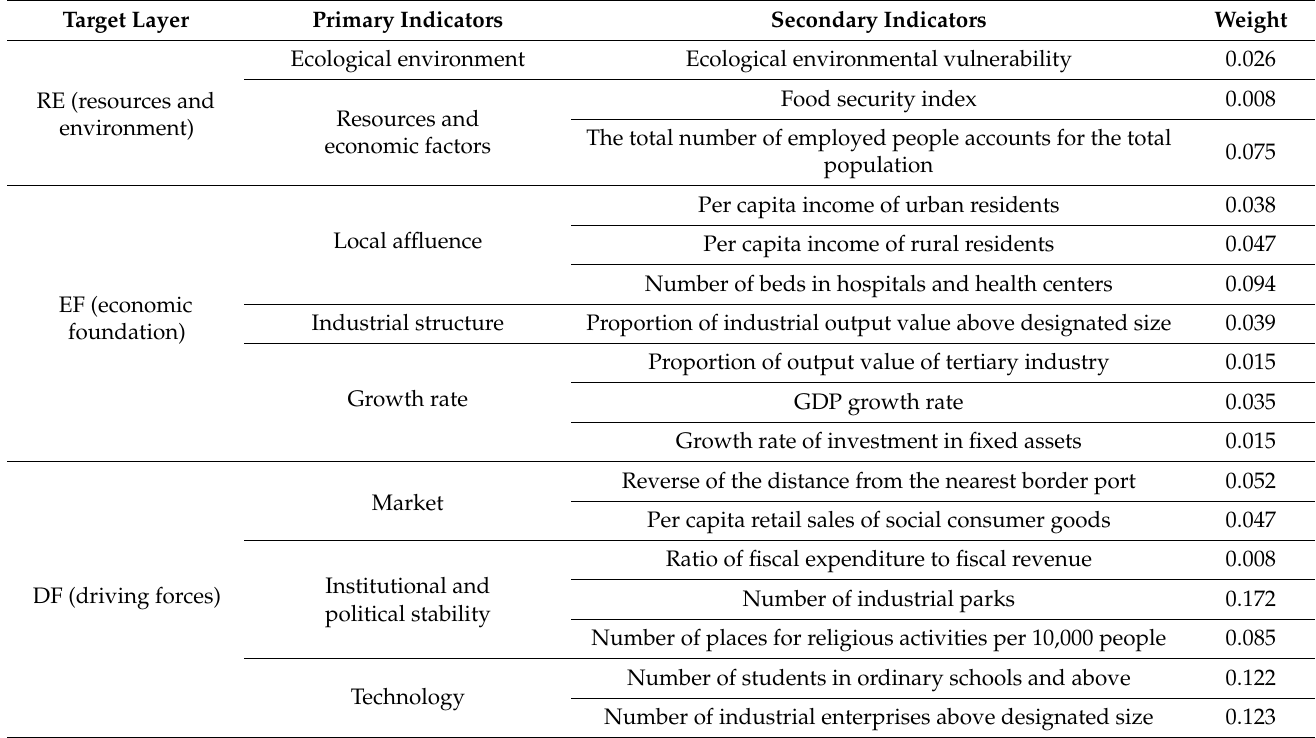
Table 3. Weight of Each Secondary Indicator Calculated by Entropy Weight Method.